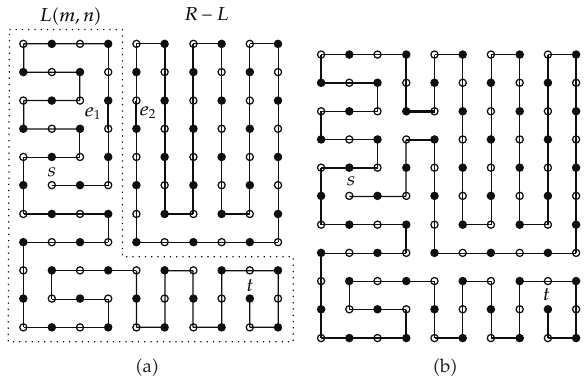
Figure 4: A Hamiltonian path in R (cid:6) 10 , 11 (cid:7)